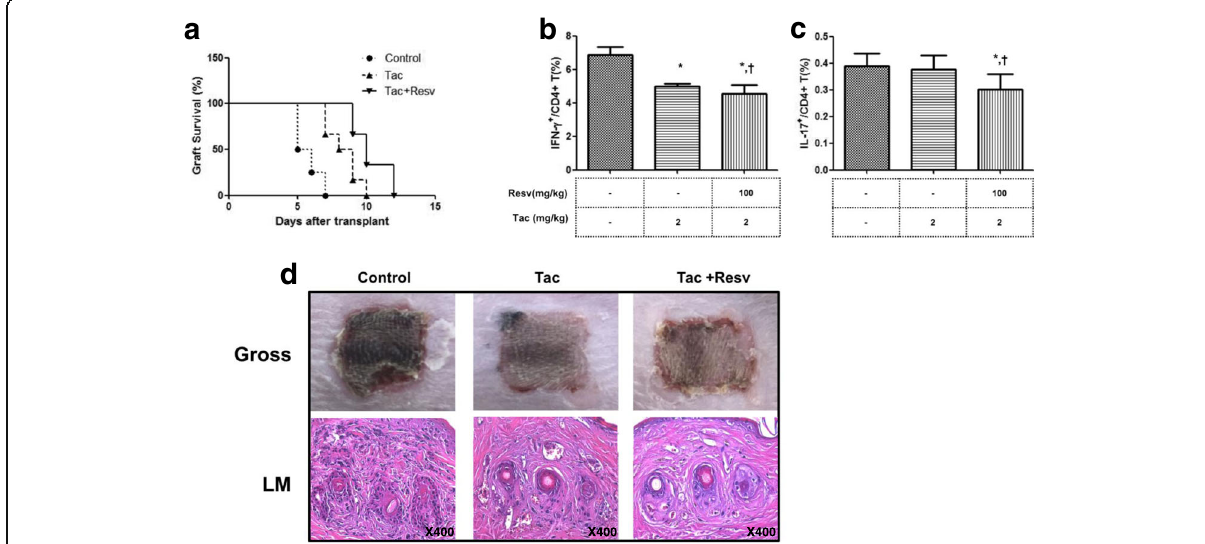
Fig. 6 Skin allograft survival in mice treated with Resv and Tac. ( a ) Kaplan-Meier Survival curve of skin allografts in each group with six animals per group. ( b , c ) The proportion (%) of IFN- γ + /CD4 + T cells, and IL-17 + /CD4 + T cells in isolated spleen cells from each group was measured via flow cytometry in six animals per group. ( d ) Histological changes in skin allografts at day 6. The inflammatory cell infiltration of the skin allograft was significantly reduced in the Tac alone group compared to the control group. Combined use of Tac and Resv further decreased inflammatory cell infiltration in skin graft tissue (Magnification × 400). *P < 0.05 vs Control † P < 0.05 vs. Tac 2 mg/kg group. Resv, Resveratrol; Tac,